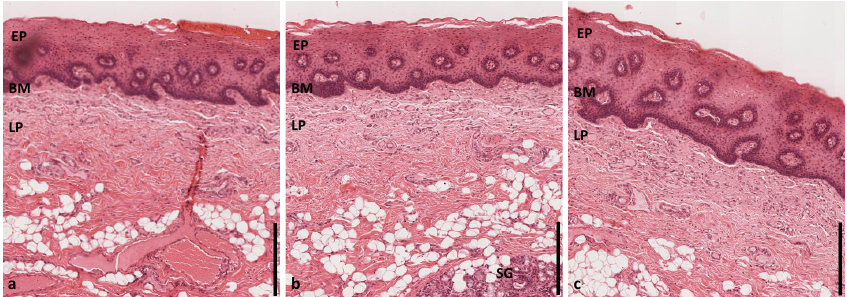
Figure A4. Supplementary HE stained histological cross sections of the human labial oral mucosa [44]. EP: epithelium, BM: basement membrane, LP: lamina propria, SG: salivary gland. Scale bar: 200 µ m.